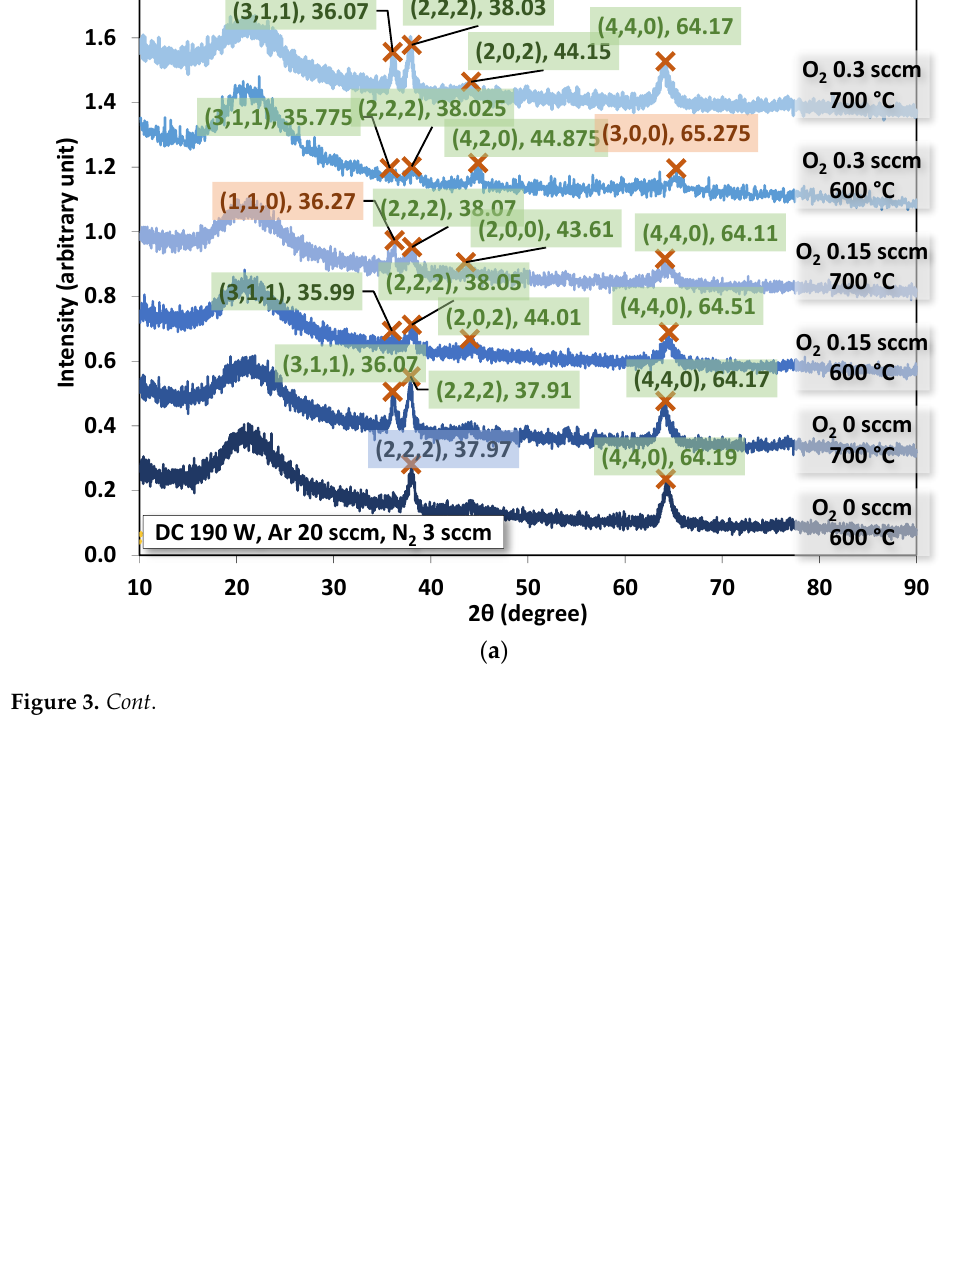
Figure 2. Variations of OES observed from the chamber plasma under different oxygen flow rates and N 2 = 10 sccm. The selected small figures are oxygen peaks located at wavelengths 458.7, 525.3, 560.7, and 844.6 nm.